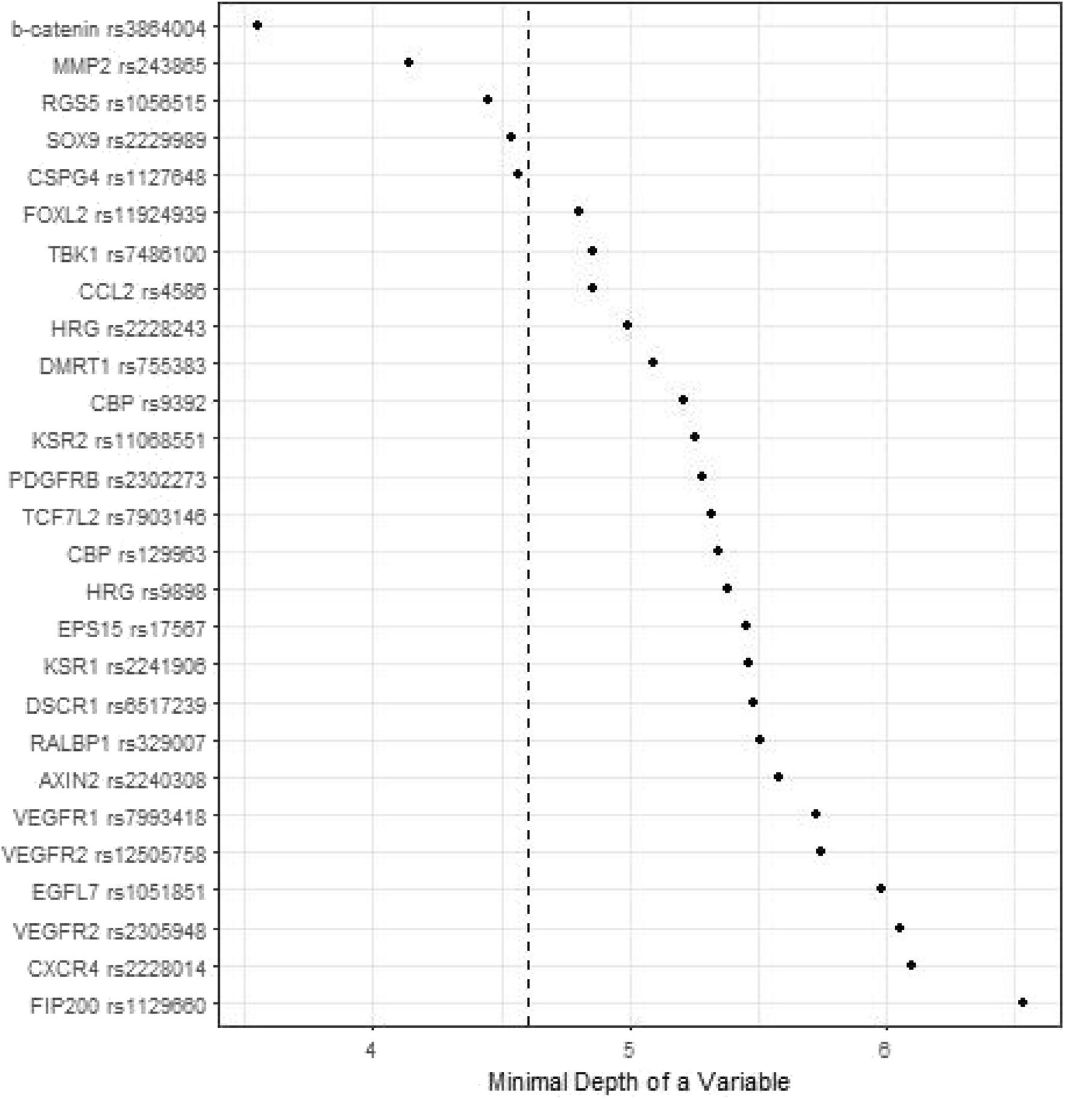
Figure 4. Minimal depth plot of 27 SNPs predicting OS in KRAS mutant mCRC patients. The most predictive SNPs in order of importance are b-catenin rs3864004, MMP rs243865, RGS5 rs1056515, SOX9 rs2229989, and CSPG4